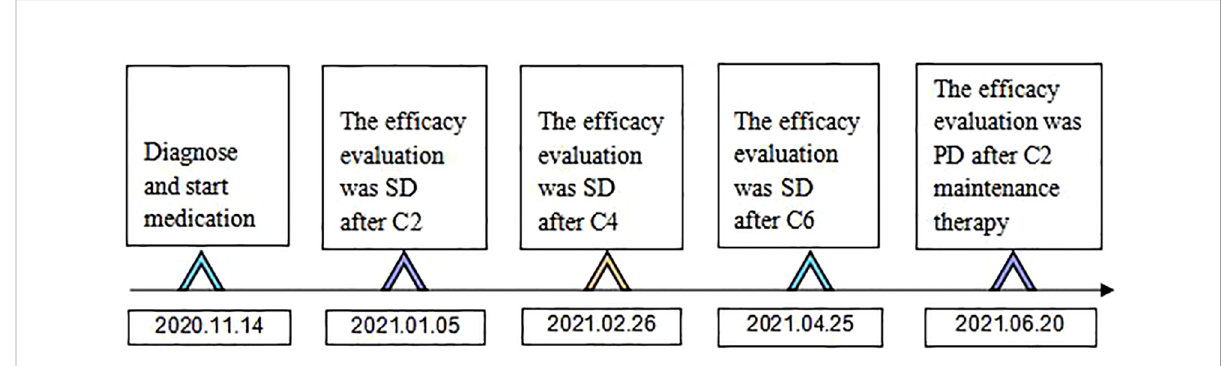
FIGURE 6 Time fl ow chart of the diagnosis and treatment process of this patient. (C2 represents 2 courses of treatment, C4 represents 4 courses of treatment, C6 represents 6 courses of treatment, C2 maintenance therapy represents 2 courses of maintenance